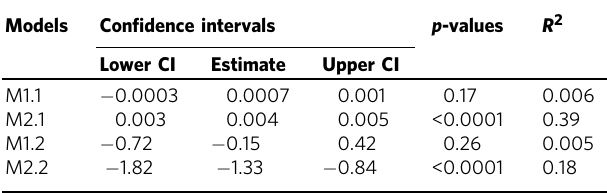
Table 3 Coef fi cients of the fi rst-order and second-order models and their con fi dence